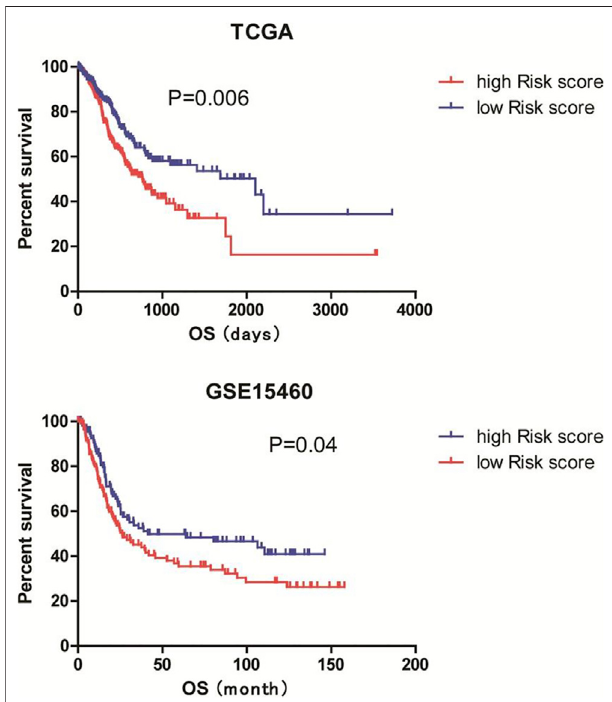
FIGURE 7 | Establishment of a 9-gene-based risk model. The risk score ofeachpatientintheTCGAandGSE15460cohortswerecalculatedbasedon the Cox coef fi cient and expression level of each gene. Patients were divided into low and high risk score groups according to the mean risk scores. Kaplan-Meier survival analysis was performed to examine the associations of risk scores with the overall survival of the TCGA and GSE15460 cohorts.